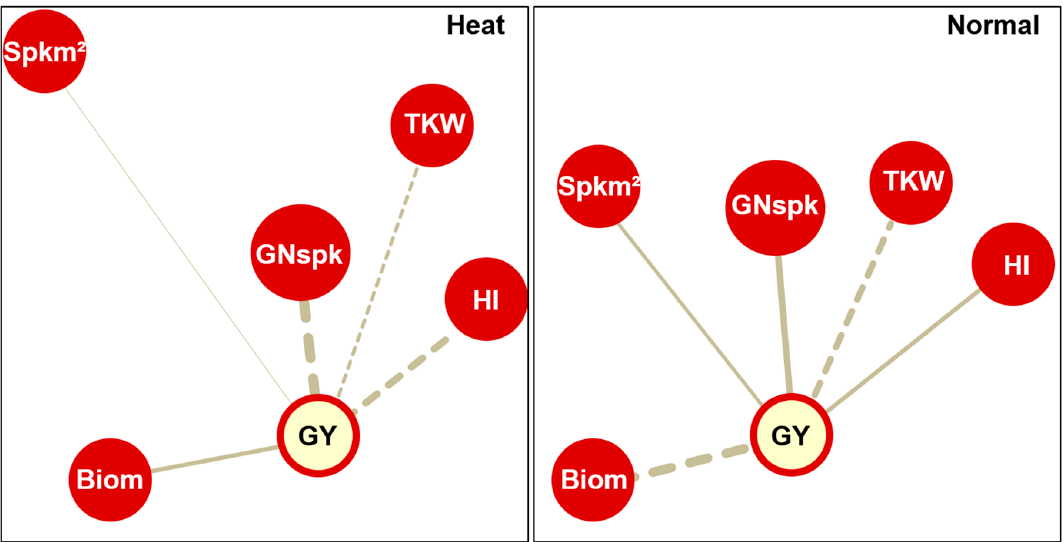
Figure 3. Relationships between grain yield (GY) and yield components (grain number per spike (GNspk), harvest index (HI), dry biomass (Biom), number of fertile spikes per meter square (Spkm 2 ), weight of a thousand kernels (TKW)) under plastic tunnel-mediated heat stress and normal conditions assessed by Pearson correlation and simple generalized additive model. The continuous grey line represents a linear relationship; the dashed grey line represents a non-linear relationship. The thickness of the line indicates the level of predictivity of the trait for GY. The length of the lines represents the correlation, the shorter the line the more the trait is correlated to GY.